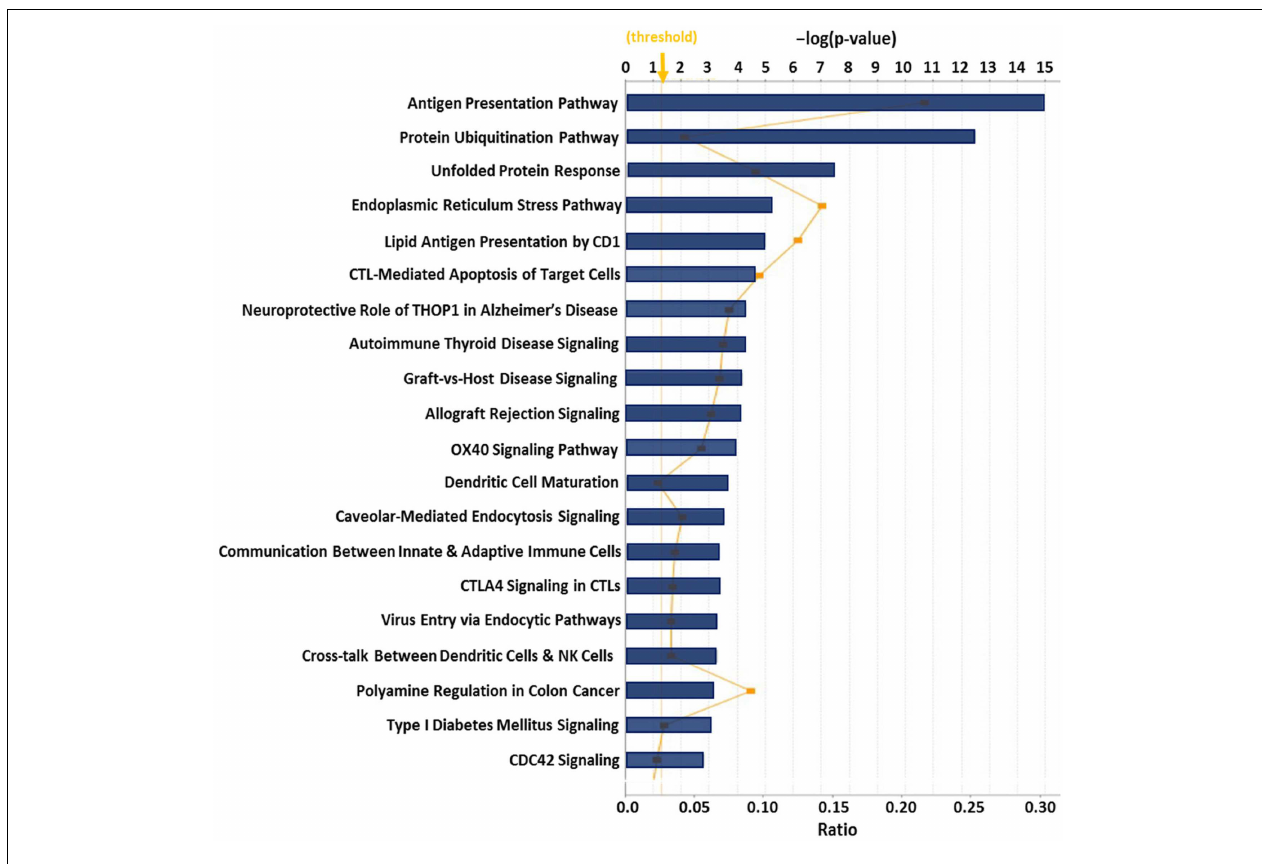
− log( p -value) from Fisher’s exact test, set here to 1.25]. “Ratio” (differential yellow line and markers) refers to the number of molecules from the dataset that map to the pathway listed divided by the total number of molecules that map to the canonical pathway from within the IPA